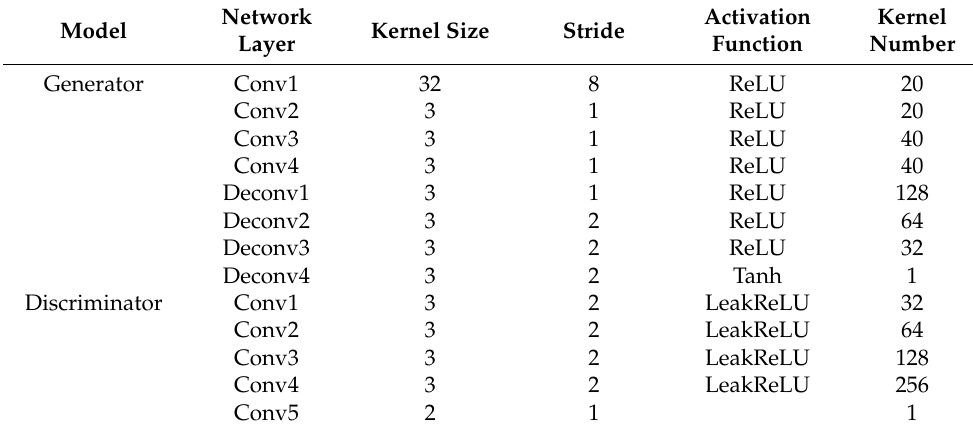
Table 2. Structure parameters and hyper-parameters of Improved